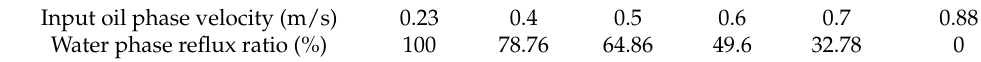
Table 3. Water phase reflux ratio at different input oil phase velocity